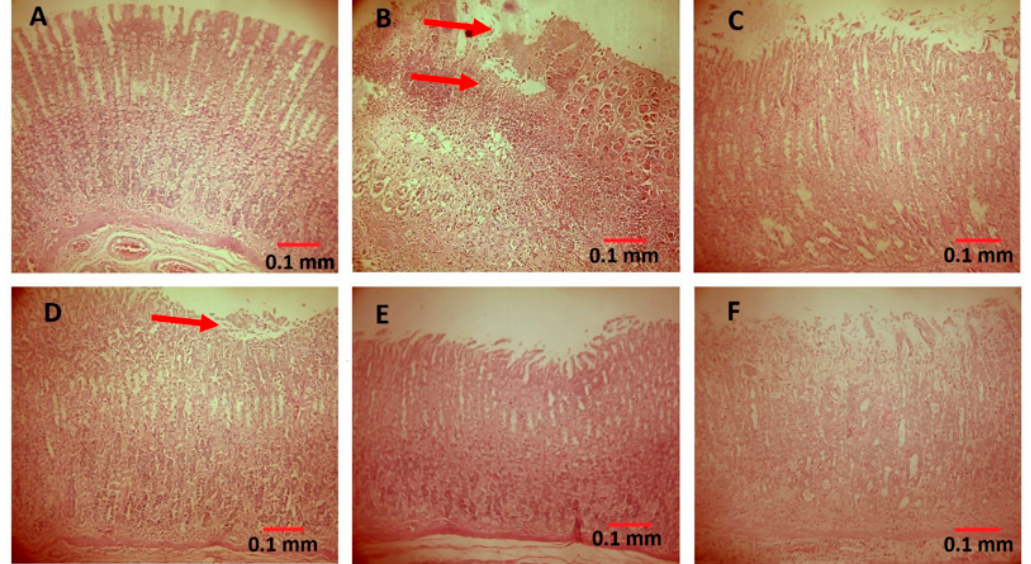
Figure 3. Histopathological analysis: Microscopic photographs of the gastric mucosa of the animals in the experimental groups, taken with a 10× objective. ( A ) Negative control group, with evident preservation of its histological architecture. ( B ) Positive control group, with erosion mainly involving the apical and intermediate region of the mucosa. ( C ) Preventive treatment group with 0.5 g of glutamine per kilogram of weight, in which a desquamation and erosion process is observed at the level of the apical region of the mucosa. ( D ) Preventive treatment group with 0.5 g of glutamine per kilogram of weight and 5 million CFU Lactobacillus reuteri , with a moderate desquamation process at the level of the apical region of the mucosa. ( E ) Regenerative treatment group with 0.5 g of glutamine per kilogram of weight, in which a moderate desquamation process is observed at the level of the apical region of the mucosa. ( F ) Regenerative treatment group with 0.5 g of glutamine per kilogram of weight and 5 million CFU Lactobacillus reuteri , with a mild desquamation process at the level of the apical region of the